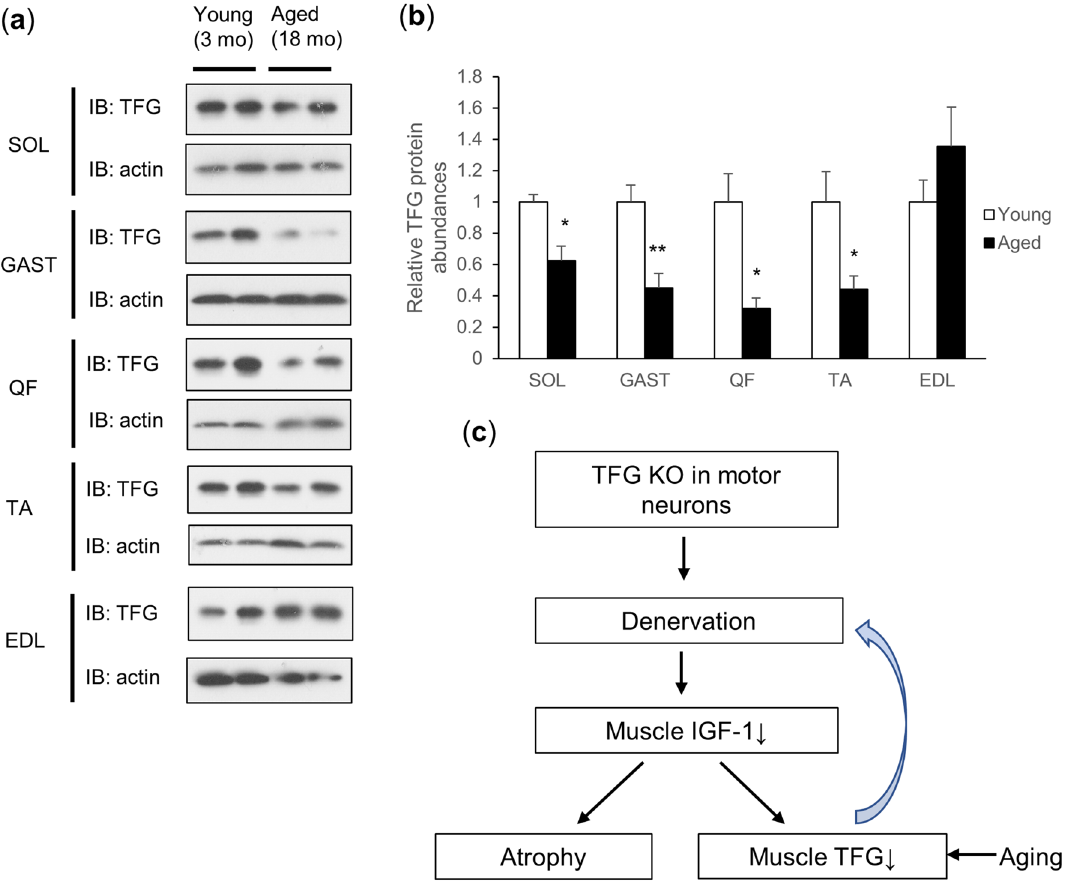
Figure 6. Muscle TFG decreases with aging. ( a ) Western blotting of SOL, GAST, QF, TA and EDL muscle samples from 3-month-old (young) and 18-month-old (aged) TFG f/f male mice. ( b ) Quantification of TFG protein abundances (adjusted by actin) (n = 5). ( c ) Summary of this study. (* P < 0.05, ** P <